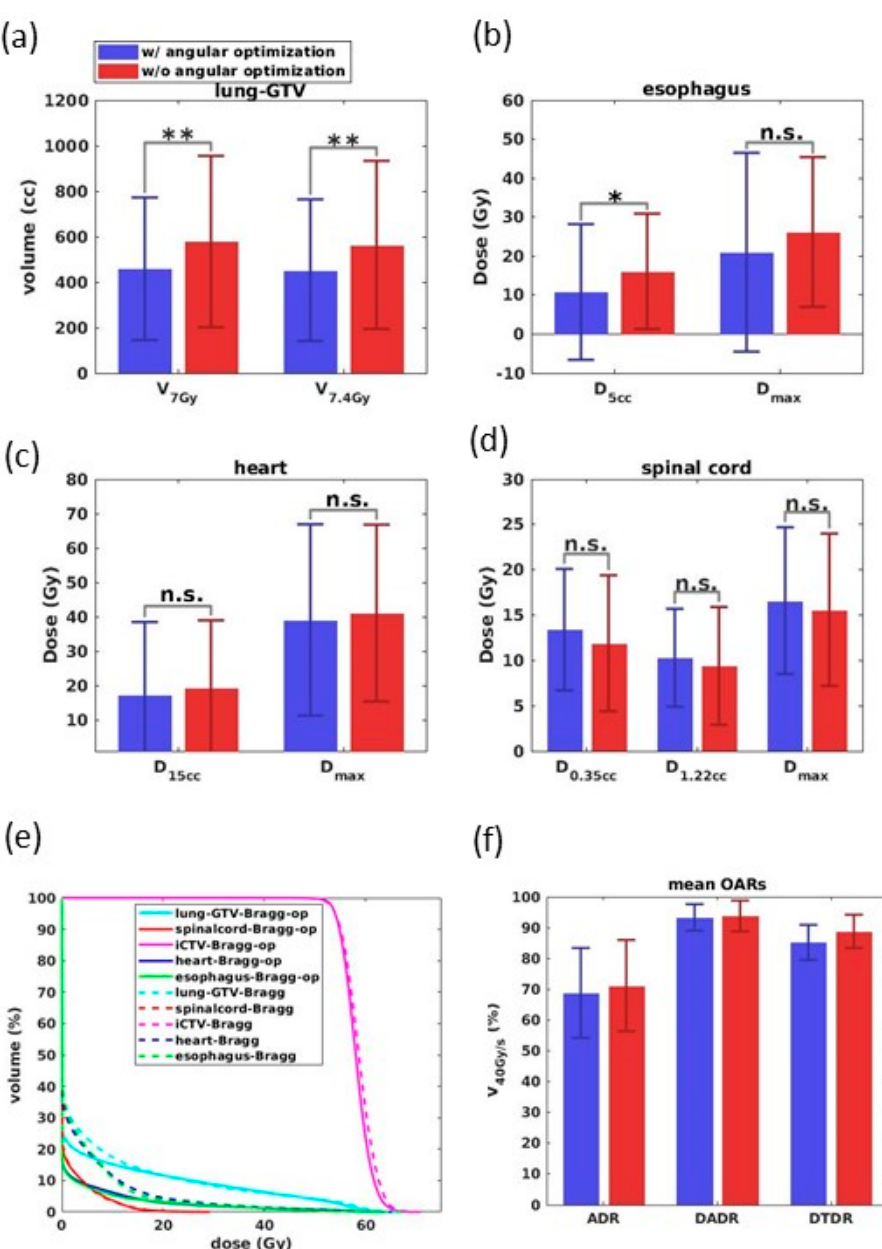
Figure 6. Barplots of dosimetry parameters for ( a ) lung-GTV, ( b ) esophagus, ( c ) heart, and ( d ) spinal cord in the Bragg peak plans with (blue) and without (red) beam angular optimization. Here, * indicates p < 0.05, ** indicates p < 0.01, and n.s. indicates non-significant. ( e ) With (solid line) and without (dashed line) angular optimization comparison by averaging the DVHs of all ten patients’ Bragg peak plans. ( f ) Barplot of the mean V 40Gy/s for all OARs based on the three-dose-rate results.